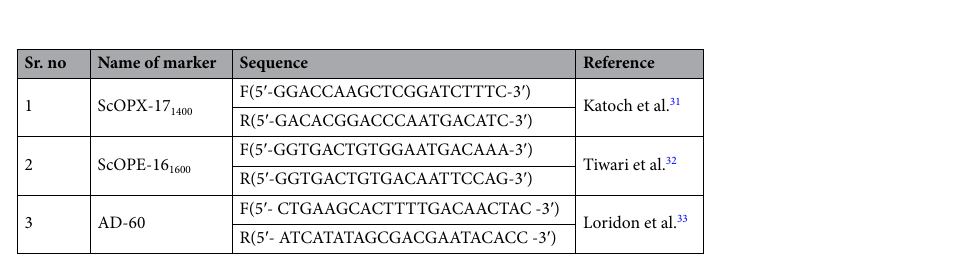
Table 3. Detail of markers used for validation.